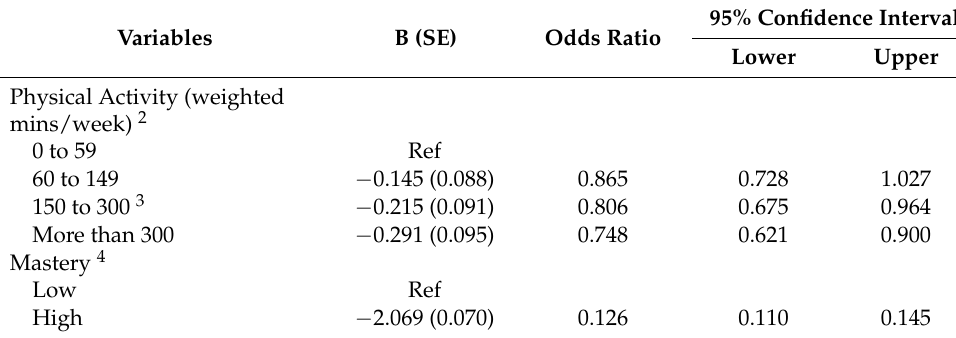
Table 4. Generalized estimating equations model of mastery and physical activity adjusted for sociodemographic and health characteristics 1